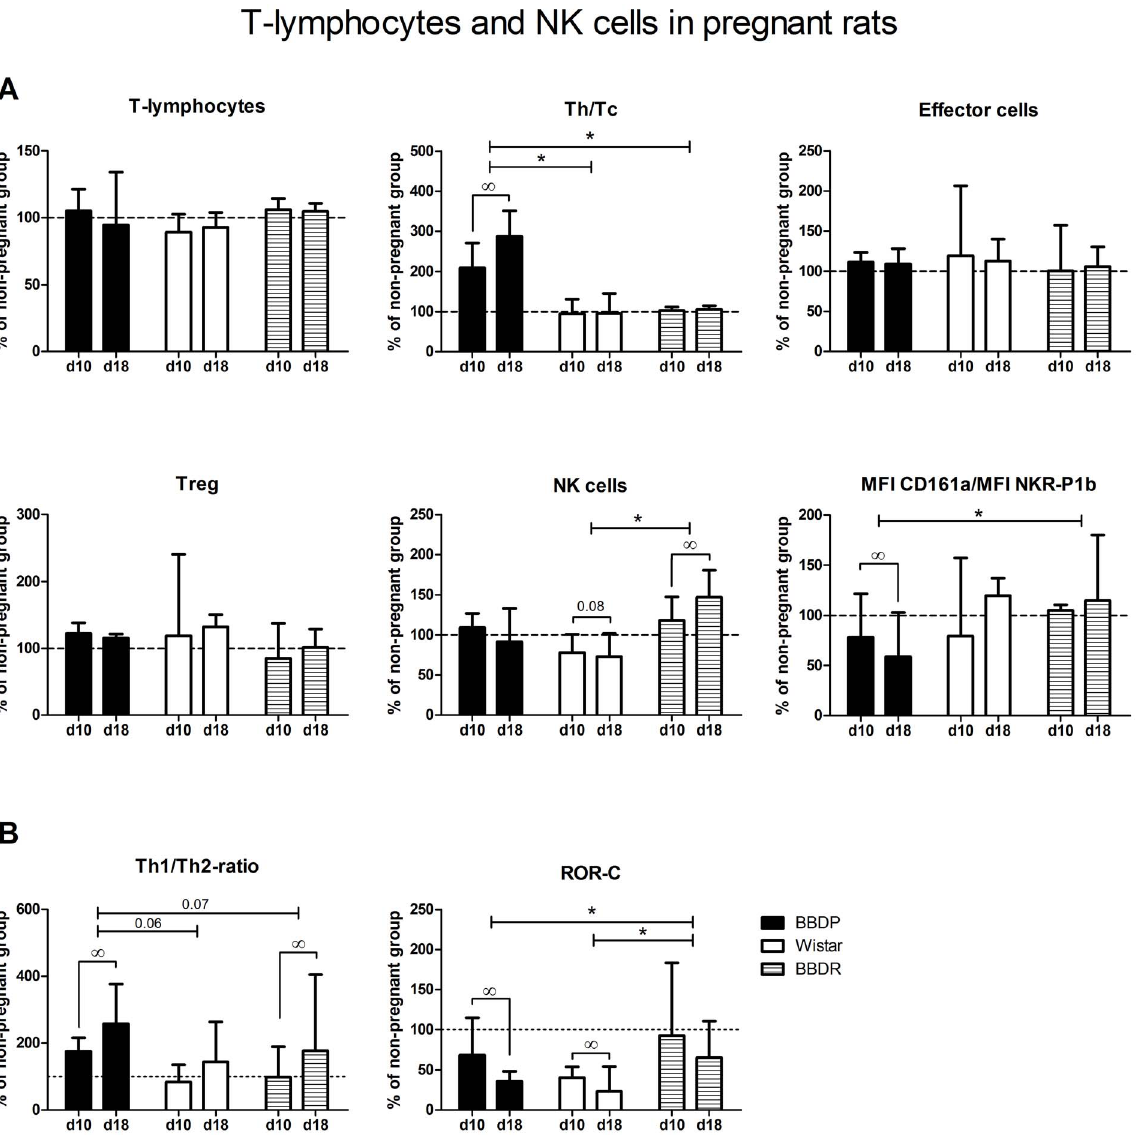
Figure 5. Lymphocyte subpopulations in pregnant rats. Values of day 10 or 18 of pregnancy are recalculated regarding the median values of non-pregnant animals (which was set at 100%) to express (as median (Q 1 –Q 3 )) pregnancy-induced changes. [A] The adaptations to pregnancy in percentage of T-lymphocytes, ratio of T-helper cells (Th) and cytotoxic T-cells (Tc), percentages of effector T-cells (Teff), regulatory T-cells (Treg), NK- cells and the ratio of MFI CD161a/NKR-P1b of NK-cells in all three strains during pregnancy. [B] The adaptations to pregnancy of the Th1/Th2-mRNA ratio and ROR-C mRNA expression in all three strains during pregnancy. d10/d18: day 10 or 18 of pregnancy. ‘ slope significantly different from zero (Regression-analysis, ANCOVA, p , 0.05). *slope significant different between the marked strains (Regression-analysis, ANCOVA, p ,